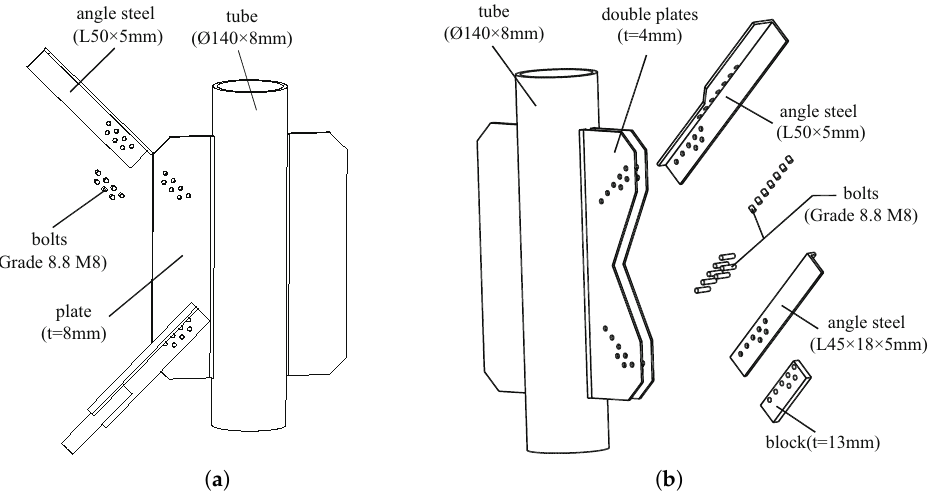
Figure 7. ( a ) The cross-sectional dimensions of the SLSPJ. ( b ) The cross-sectional dimensions of the